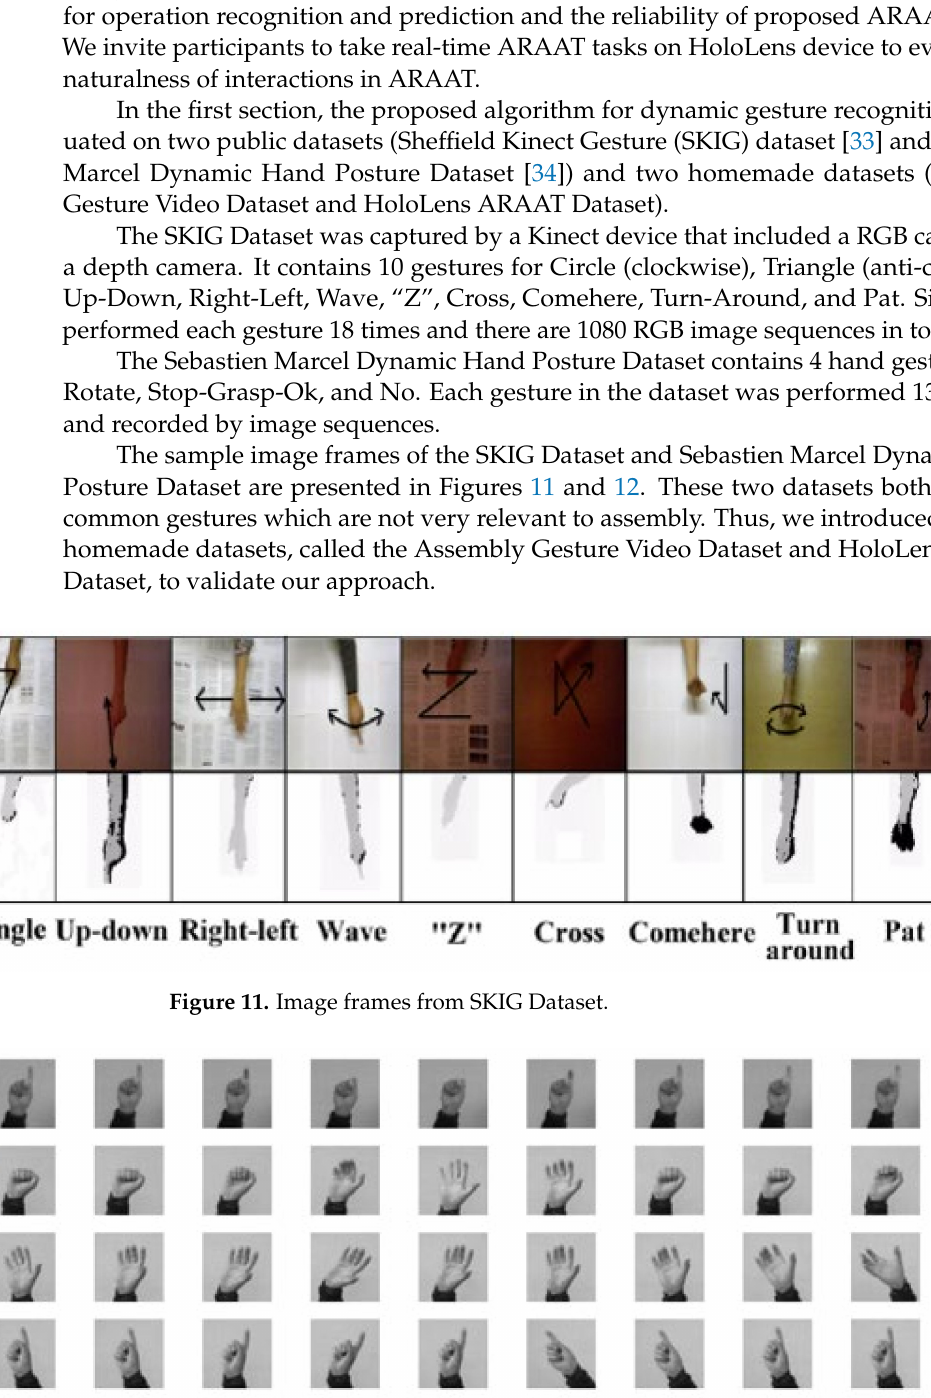
Figure 12. Image frames from Sebastien Marcel Dynamic Hand Posture